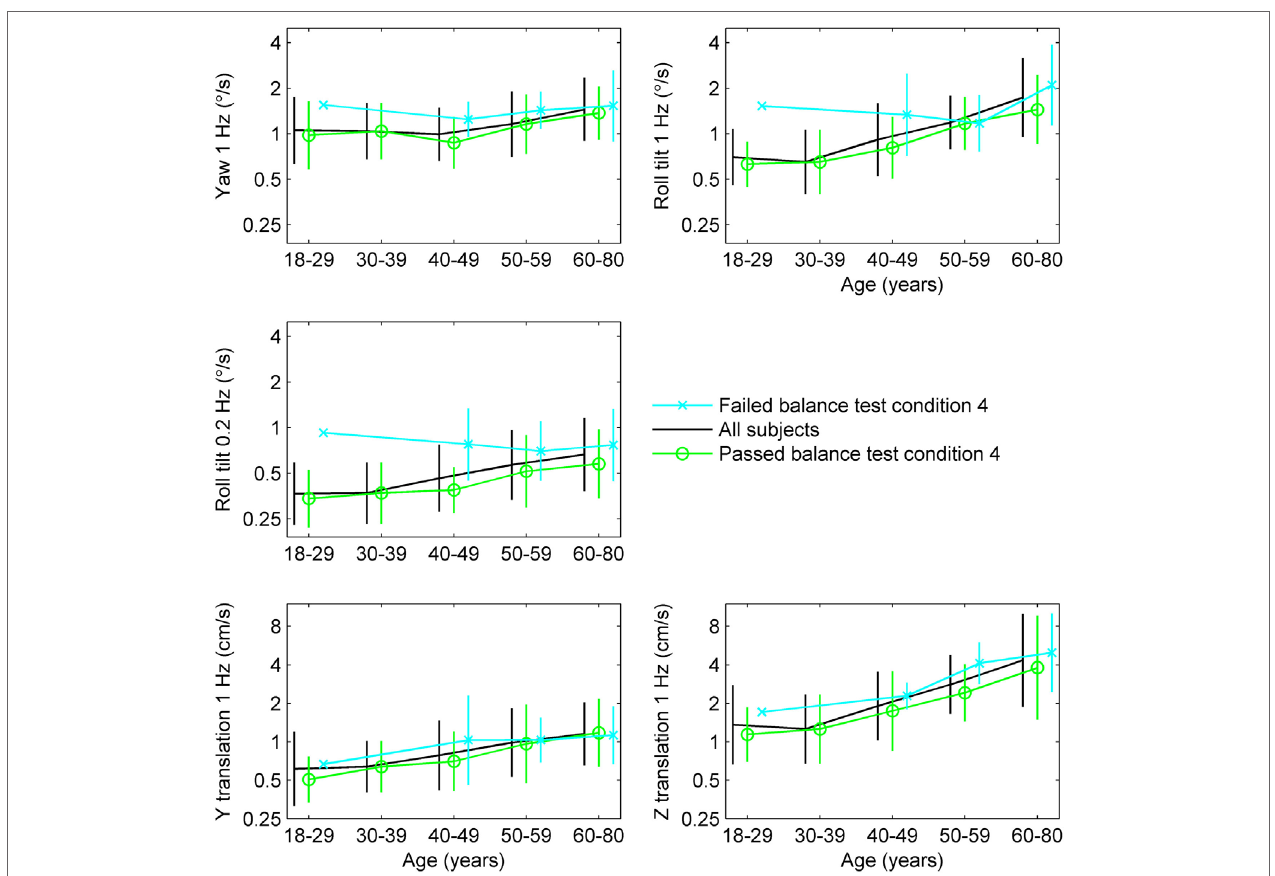
FigUre 2 | Thresholds segmented by age group and results of condition 4 of the balance test, with error bars showing